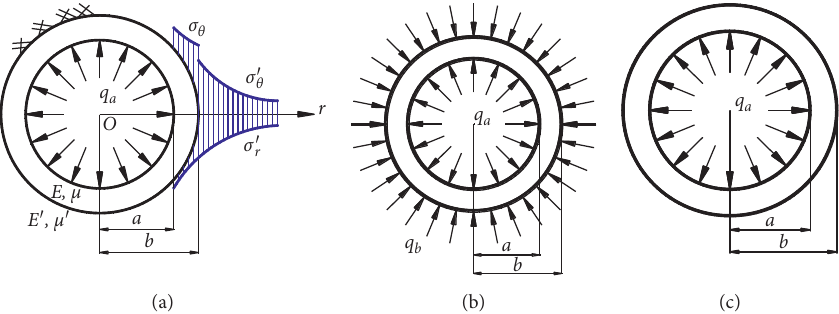
Figure 2: Stress distribution of the shaft wall. (a) Stress distribution of the silo wall mechanical model. (b) Equivalent diagram of internal and external pressure model on the silo wall. (c) Equivalent diagram of the internal pressure model on the silo